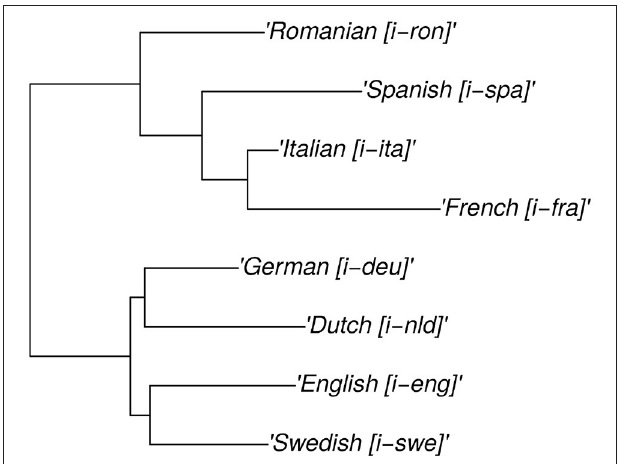
FIGURE 1 | Phylogenetic tree for the eight Indo-European languages represented in the complexity sample.